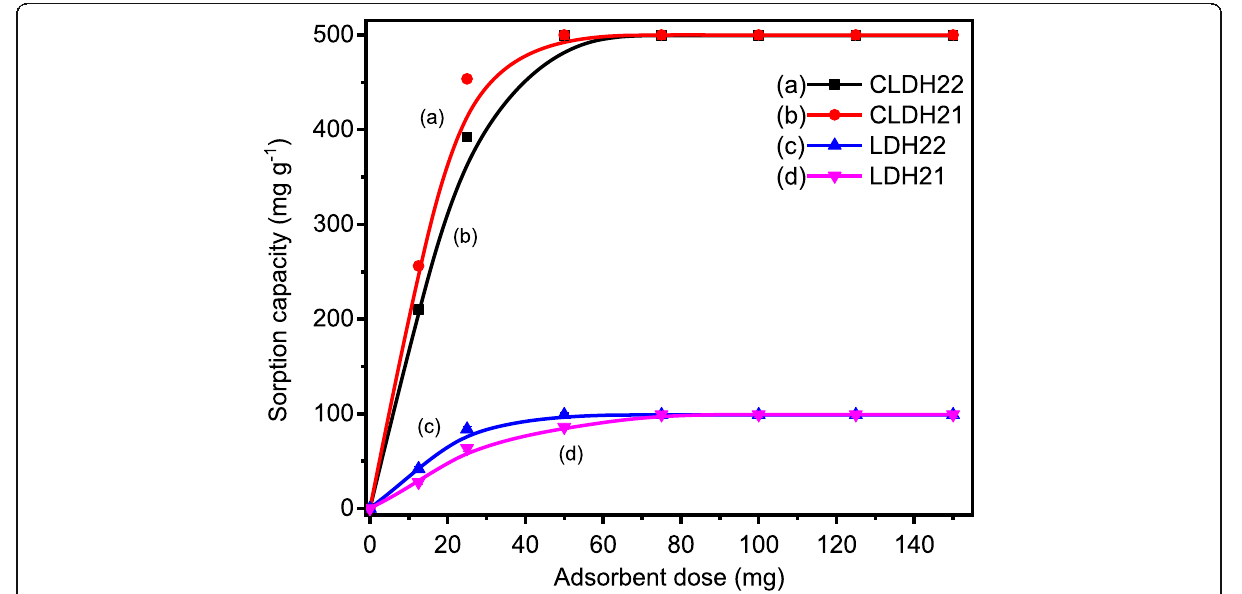
Fig. 6 Effect of adsorbent dose on adsorption capacity of IDB onto LDHs and CLDHs adsorbent, C i = 100 and 500 mg L − 1 , V = 25